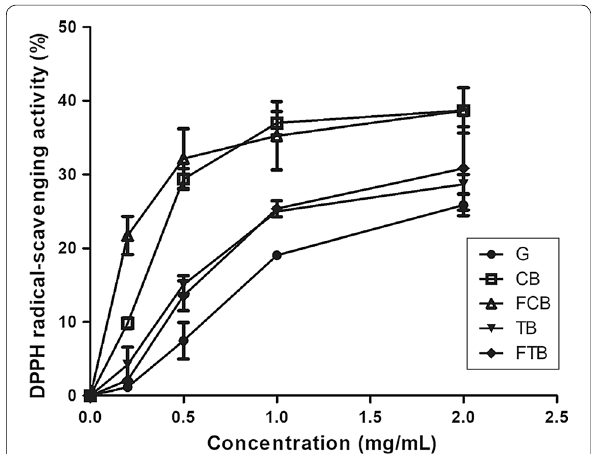
Fig. 1 DPPH radical scavenging activities of ethanol extract of oyster mushroom fruit body. G basal medium, CB common buckwheat medium, FCB fermented common buckwheat medium, TB tartary buckwheat medium, FTB Fermented Tartary buckwheat medium. Each mean value was written with standard error of the mean (SEM)